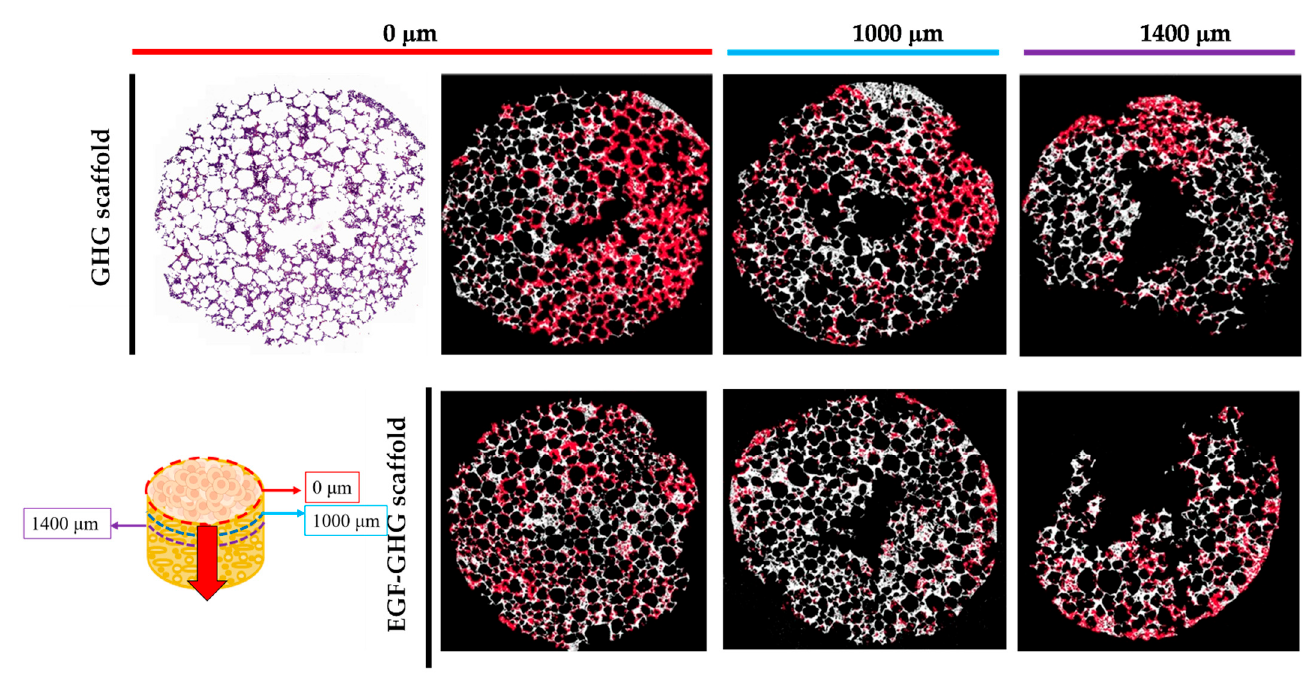
Figure 6. The migration of MDA-MB-231 in dynamic culture until the third day: the scaffold was sectioned from top to bottom (0th, 1000 and 1400 µm) after three days of culture and the effects of EGF on metastasis were observed. The estimated distribution of cells on the GHG scaffold was (from top to bottom) 100, 51, and 31%; when EGF was immobilized on the scaffold, the distribution was 100, 74, and 65%. The cell numbers at the beginning (0th mm) of scaffold slices was set to 100% (scale bar: 2000 µ m),